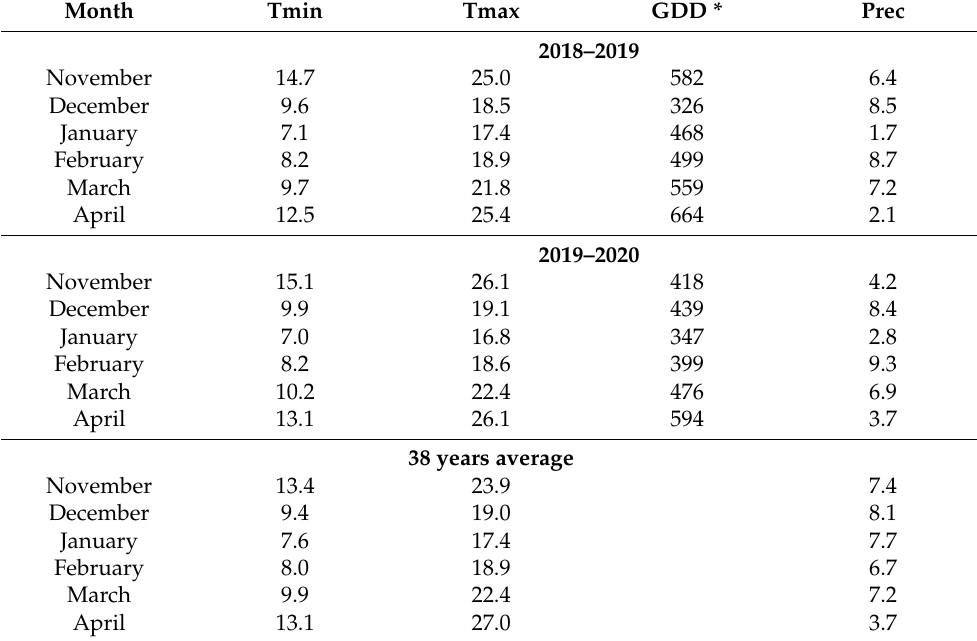
Table 1. Monthly average minimum temperature (Tmin, ◦ C), maximum temperature (Tmax, ◦ C), growing degree days (GDD, ◦ C) and precipitation (Prec., mm) in the two growing seasons and 38 years monthly averages (1983–2020).